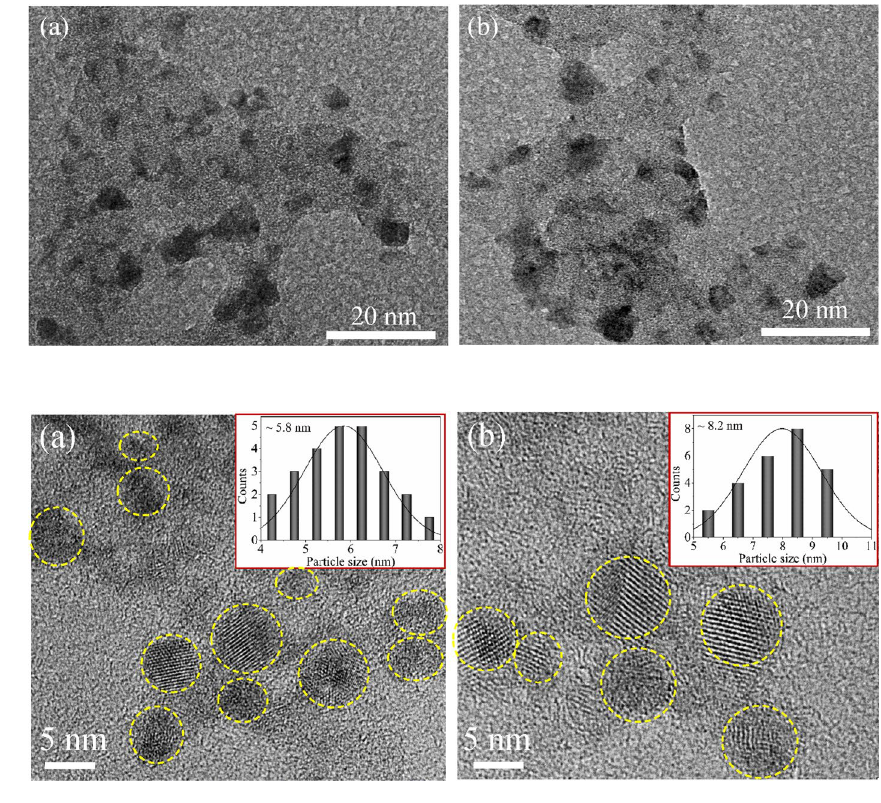
Fig. 1 TEM images of CdTe particles for the samples, a S and b S , respectively 4